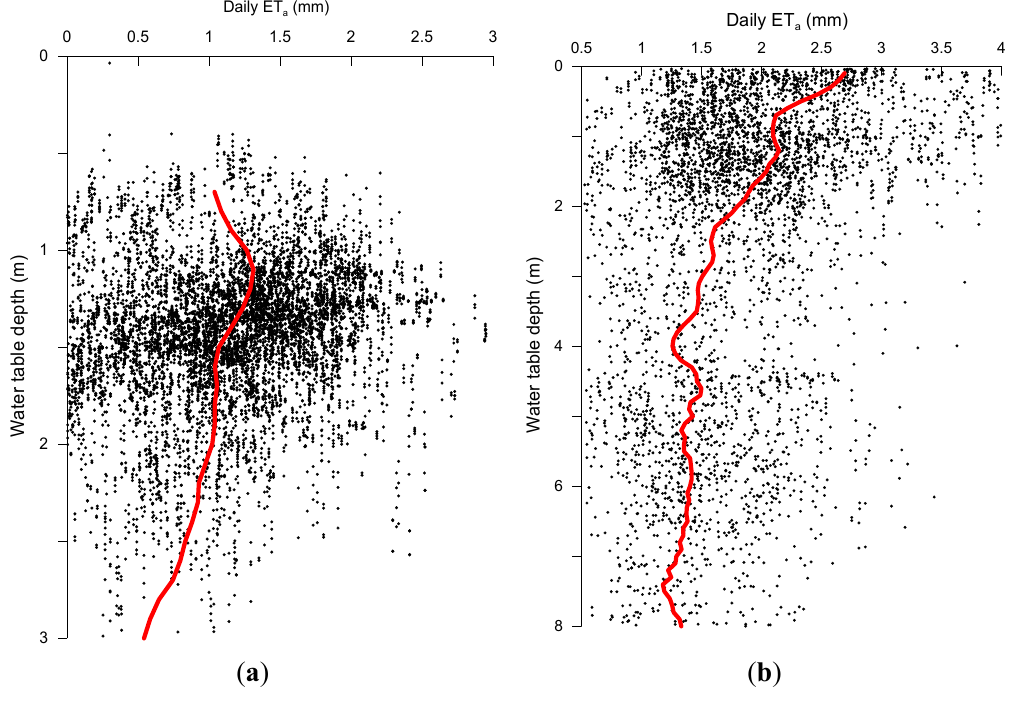
Figure 12. The scatter plot of daily ET ( b ) DXS in June